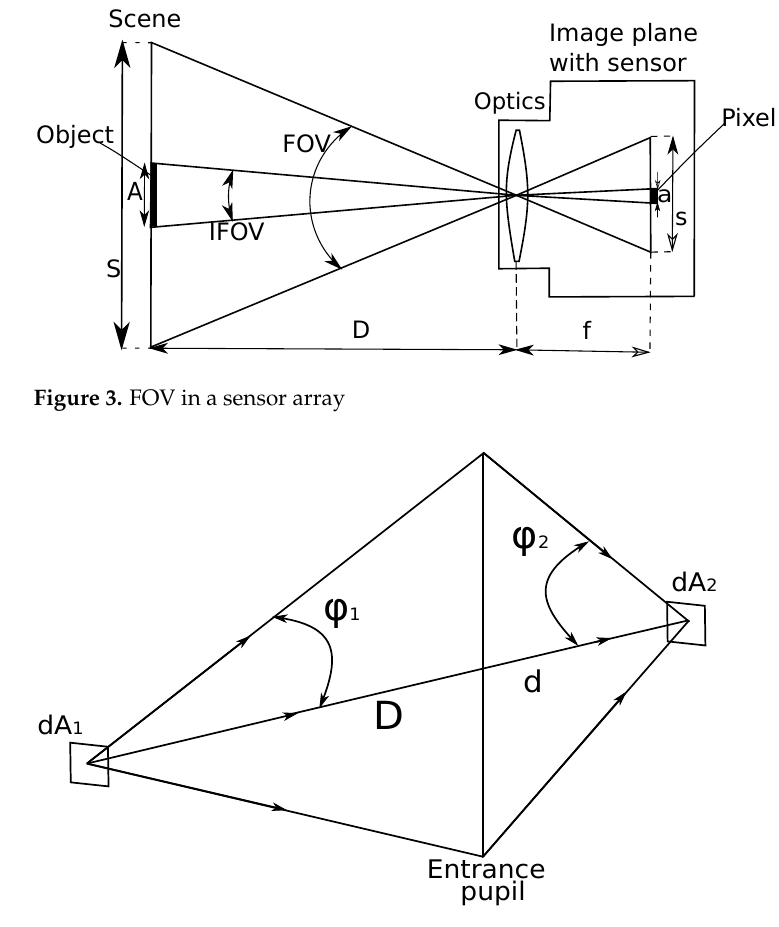
Figure 4. Path of the IR radiation from the object to the Figure 3. Path of the IR radiation from the object to the image PixelScene Object